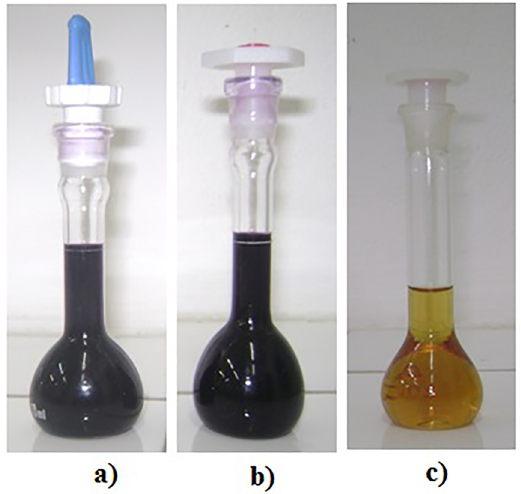
Figure 4. DPPH radical results: a) DPPH solution, b) DPPH+ZnS and c) DPPH+BHT.